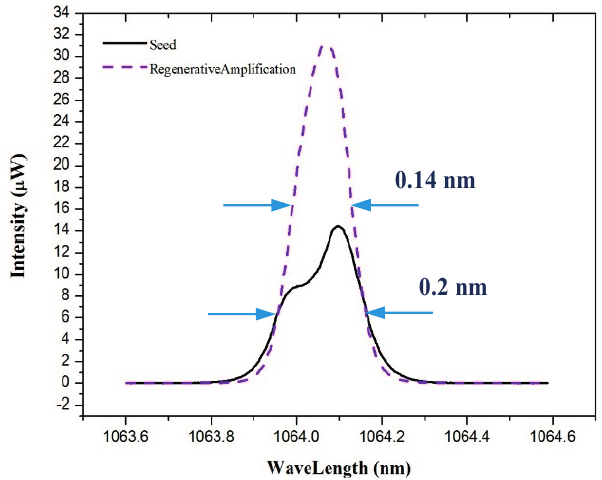
Figure 6. Spectral intensity distribution of the injected seed (solid line) and regenerative amplified output (broken